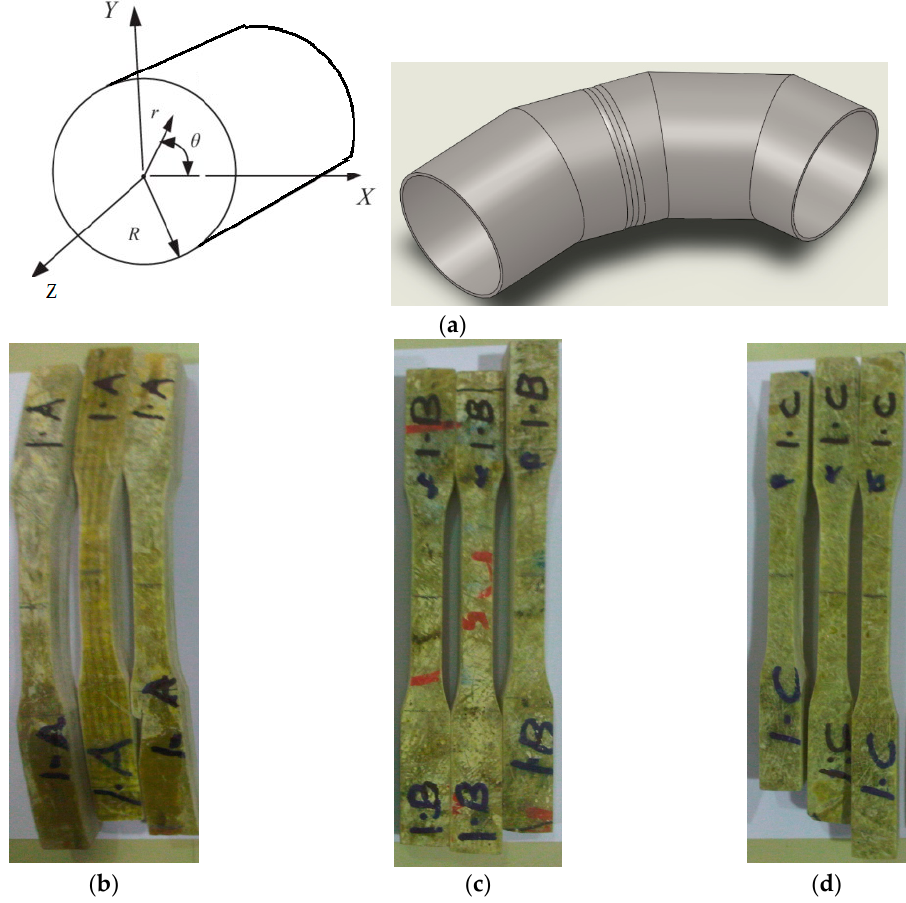
Figure 7. (a) The pipe section shows the coordinate system (r, θ , z); (b) Hoop specimens (along θ direction); (c) Axial specimens (along the z-direction); (d) 45 ° direction specimens.